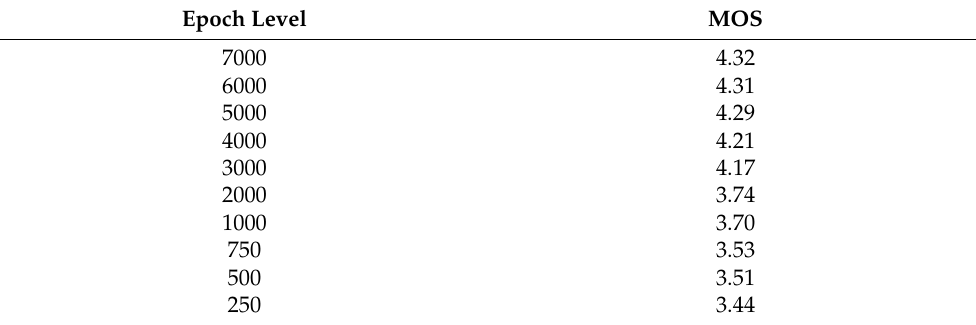
Table 7. MOS-LQO comparison synthesized